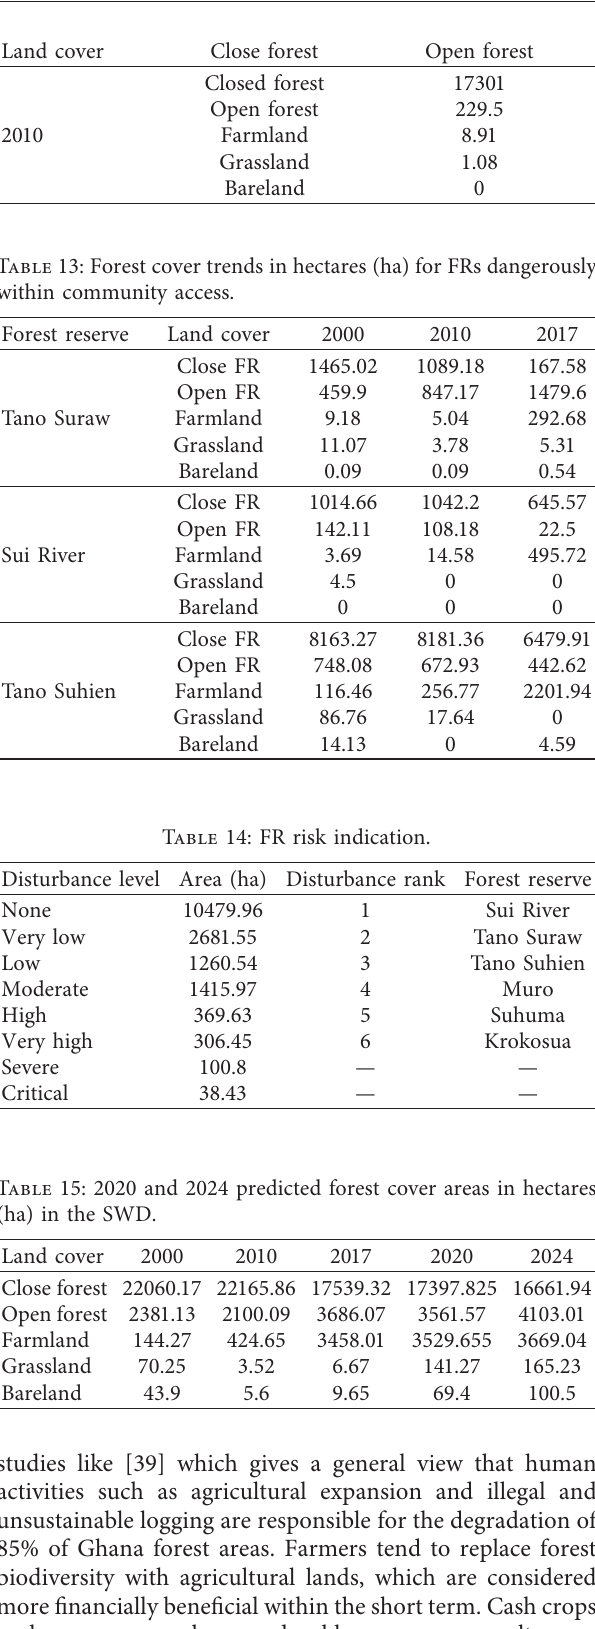
Table 12: 2010–2017 forest to farmland conversion in hectares (ha).